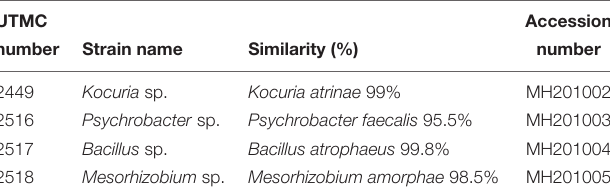
TABLE 3 | Molecular identification of marine fouling bacteria based on 16S rRNA